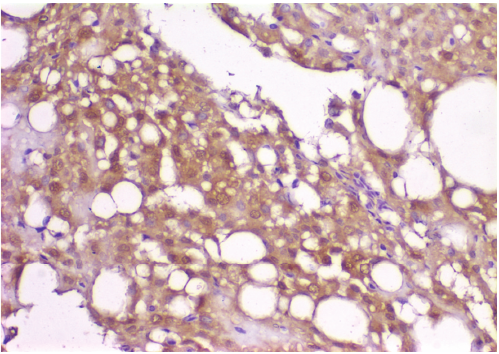
Figure 2: Picture shows CK5/6 positive cells in the lesion (this antibody was used to search for a mesothelial